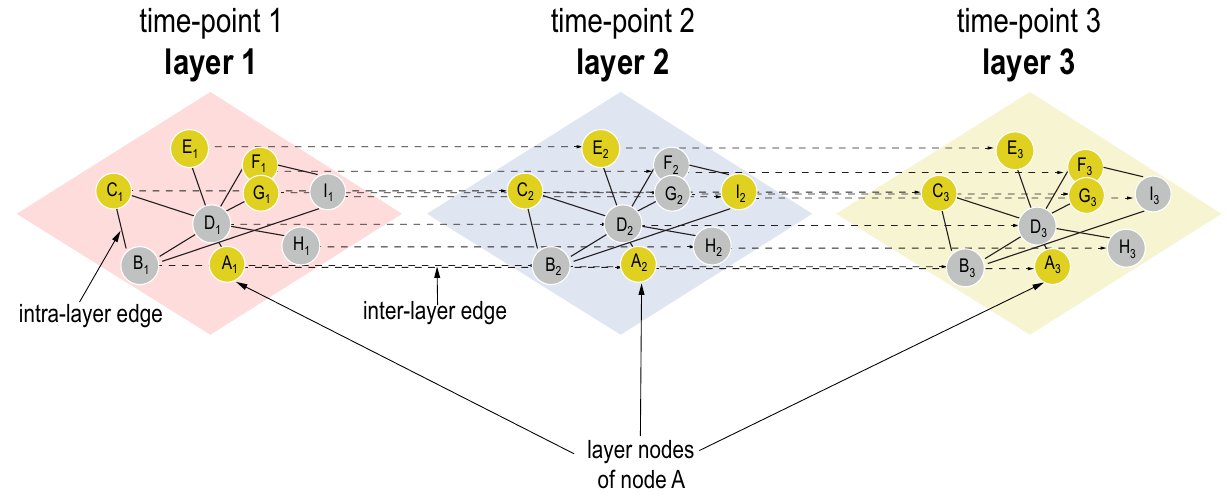
Figure 1. Basic structure of a temporal multilayer network (tMLN). Here shown is a tMLN of three layers. Each layer of the network contains the same protein–protein interaction network (PPIN). Nodes within one layer ( layer-nodes ) are connected via intra-layer edges , the same node between two layers is connected by an inter- layer edge . For example, the layer-nodes from a given node A (A 1 , A 2 , A 3 ) are successively linked by inter-layer edges (A 1 → A 2 → A 3 ). Numerical data, such as differential expression data from a time-series RNA-sequencing study, are integrated with the TimeNexus tMLN, whereby one layer represents one time point. Yellow nodes represent query nodes , which need to be defined a priori by the user. Query nodes can for instance be chosen based on significant differential expression of genes at a given time point versus a control and provided with a node weight. Grey nodes connect query nodes but are themselves not significantly differentially expressed. Intra-layer edges could contain weights in form of confidence values of the given interaction. Inter-layer edges should contain weights describing the change in expression of one node between the two connected